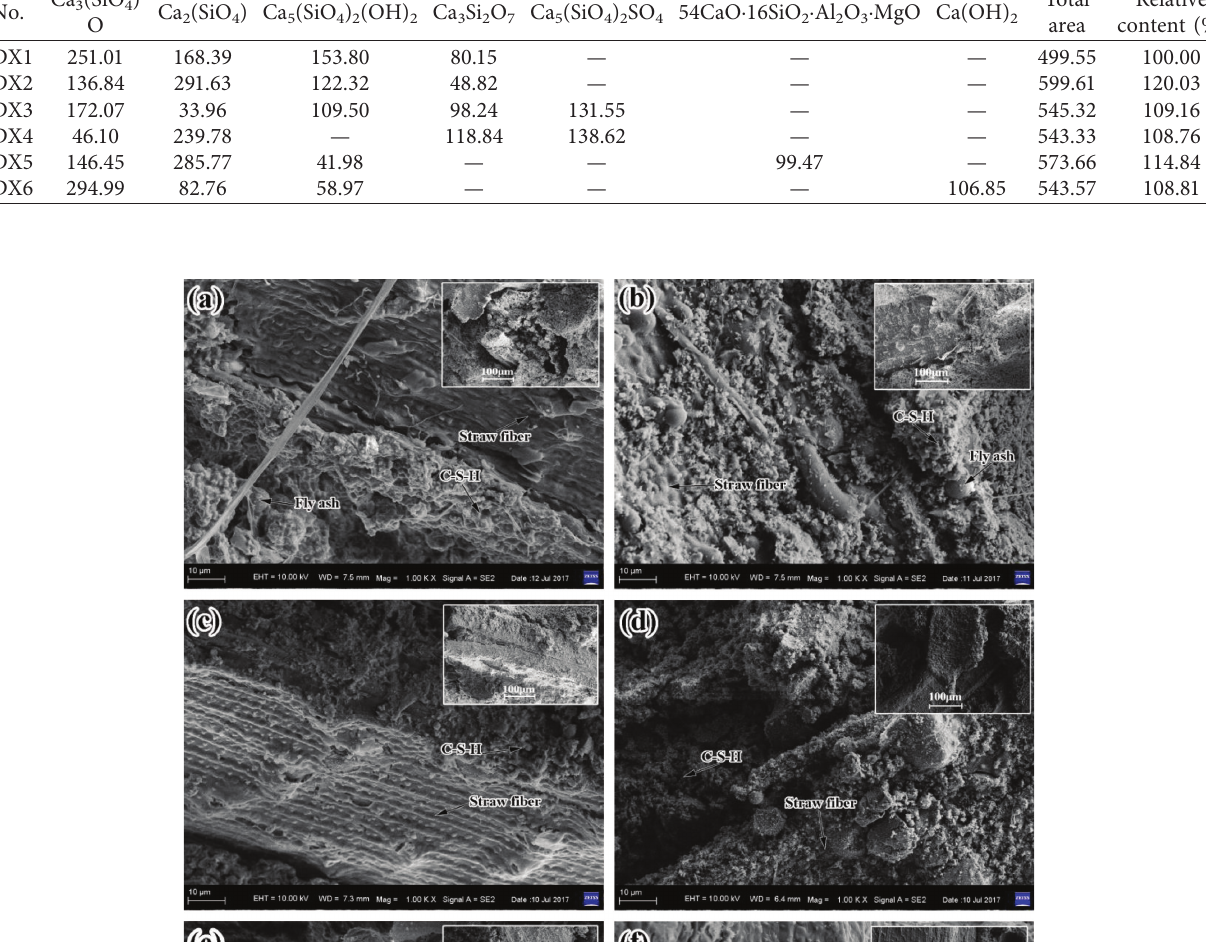
Table 6: The diffraction peak area of each phase and the relative content of total hydration products of SFCC. Ca 3 (SiO 4 ) No. O